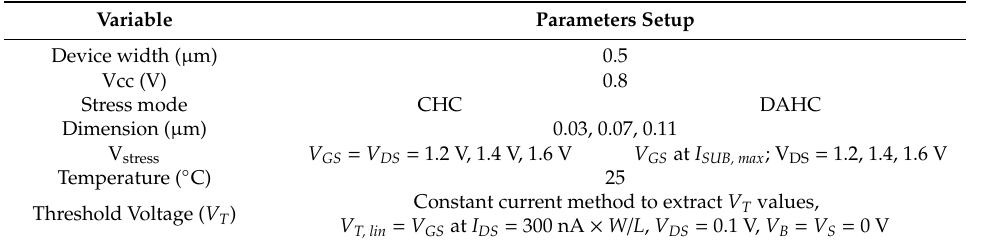
Table 3. Test conditions under HC